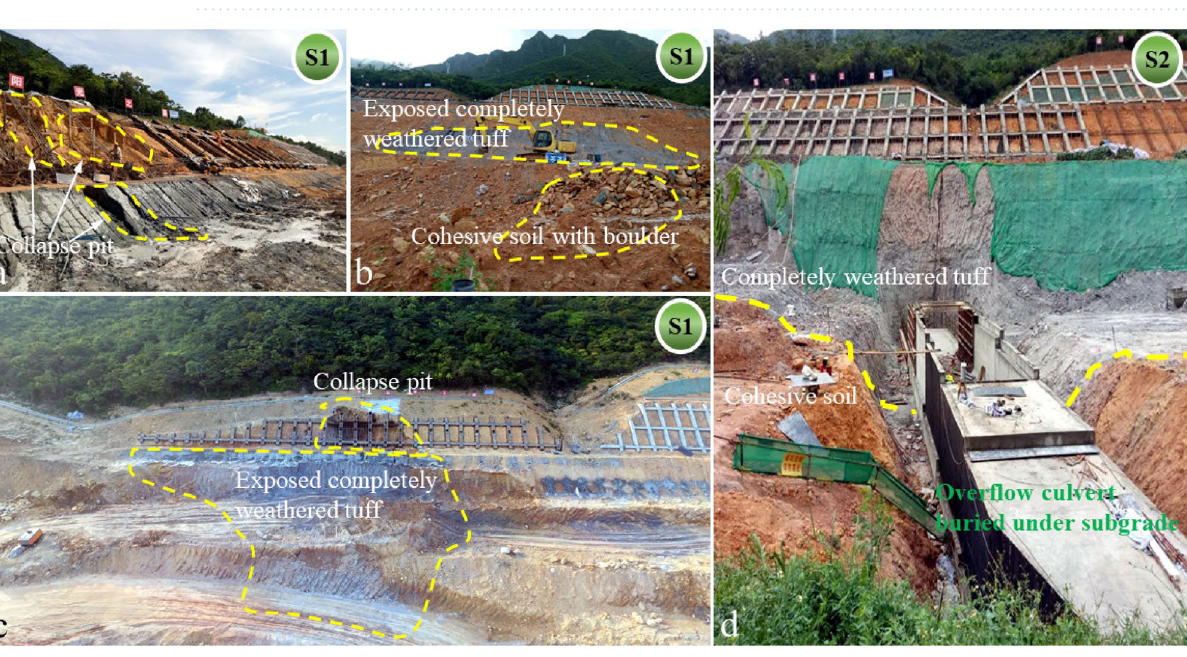
Figure 9. Evolution process and typical events timeline of the Baguang toll gate landslide from May 2017 to September 2018 (S1, S2, S3 represents the time nodes in the construction process, E1-E11 represents the time node when the slope gradually tends to instability after construction).